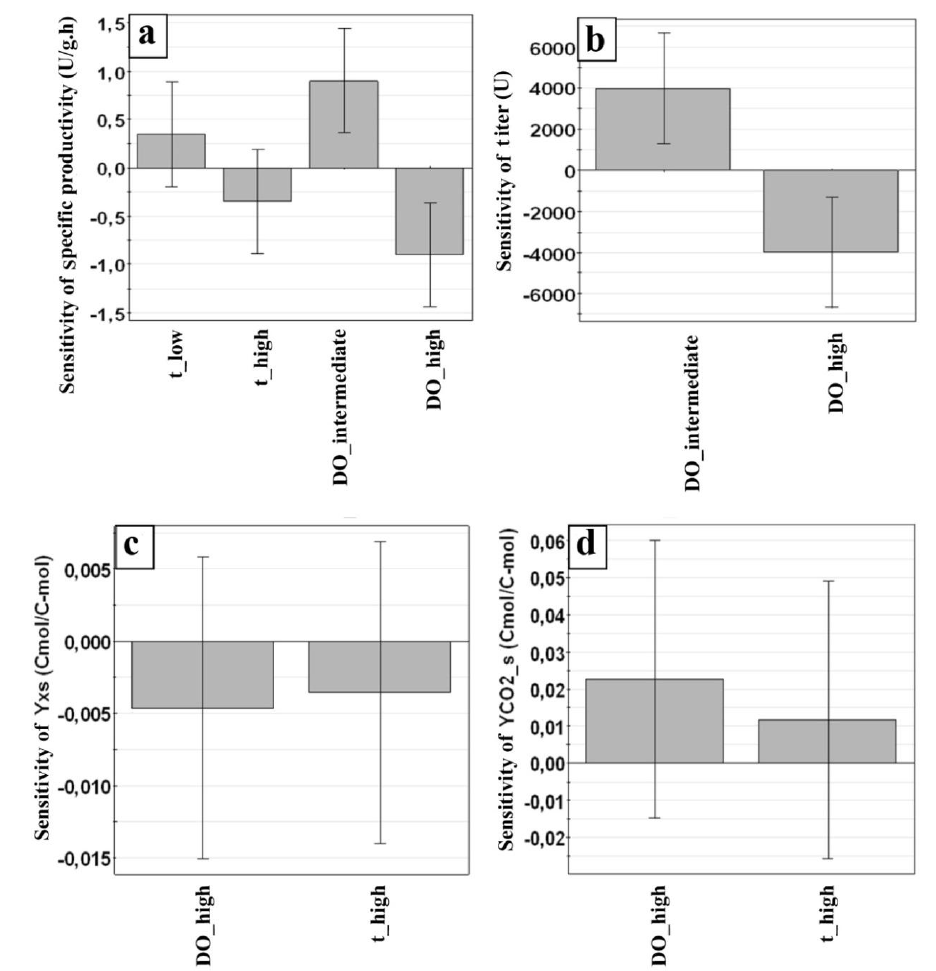
Figure 3. Coefficient plots for the models which correlate dissolved oxygen (DO) and residence time (t) as qualitative factors to the ( a ) specific productivity ( b ) titer ( c ) biomass yield (Y ) ( d ) carbon dioxide yield (Y XS CO2s